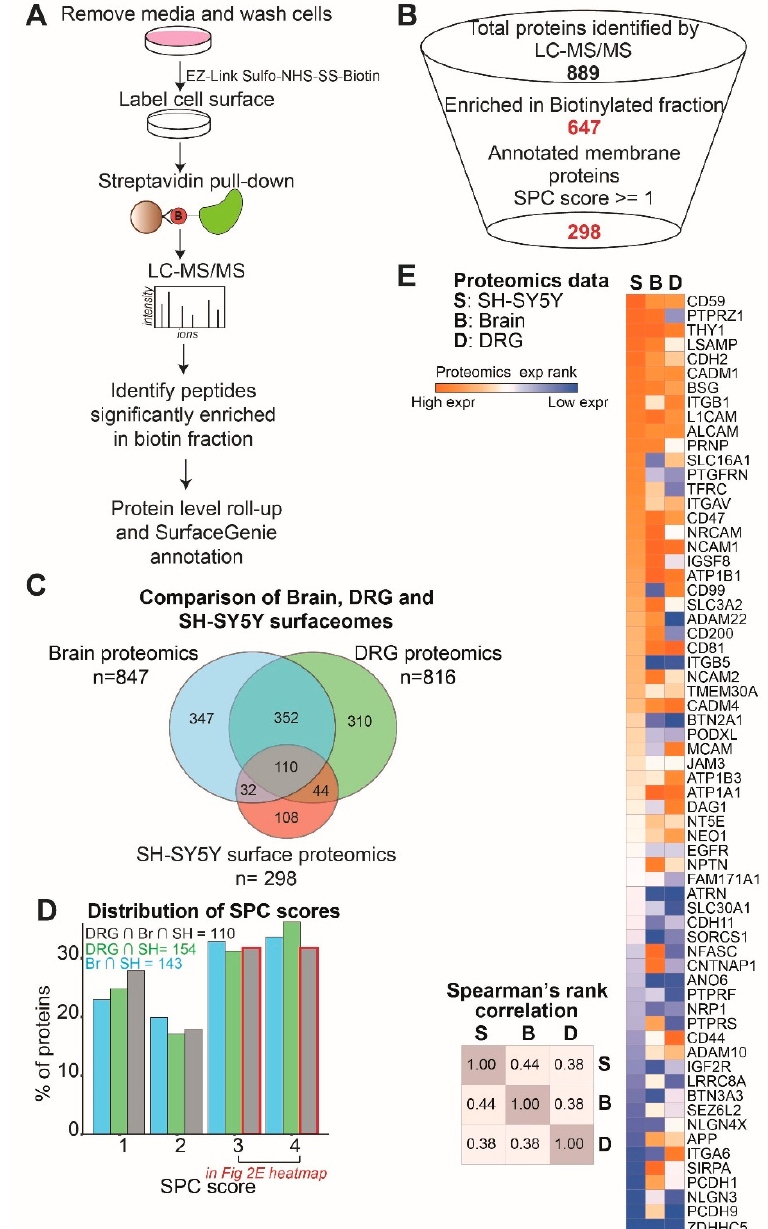
Figure 2. Surface proteomics identifies nearly 300 SH-SY5Y membrane-associated proteins. ( A ) An experimental workflow for cell surface labeling followed by proteomics. ( B ) Bioinformatic selection funnel used to identify biotin-labeled proteins and select for high-confidence surface proteins. Pro- teins enriched in biotin compared to control fractions listed in Table S2. ( C ) Venn diagram showing the overlap between membrane proteins identified in brain and DRG neurons as well as SH-SY5Y cells. The overlap of each pairwise comparison shown here is statistically significant, as calculated by the hypergeometric test ( p -values < 2.2 × 10 − 16 ). All proteins common to all three classes and their expression ranks are listed in Table S3. ( D ) Distribution of SPC scores for pairwise comparisons including SH-SY5Y cells shown in ( C ) and for proteins present in all three classes. ( E ) Heatmap of the brain and DRG proteomics as well as SH-SY5Y surface proteomics ranked expression of high- confidence (SPC score ≥ 3) surface proteins common to all 3 datasets (left). Heatmap of Spearman’s rank correlation for pairwise comparisons of protein expression in the three